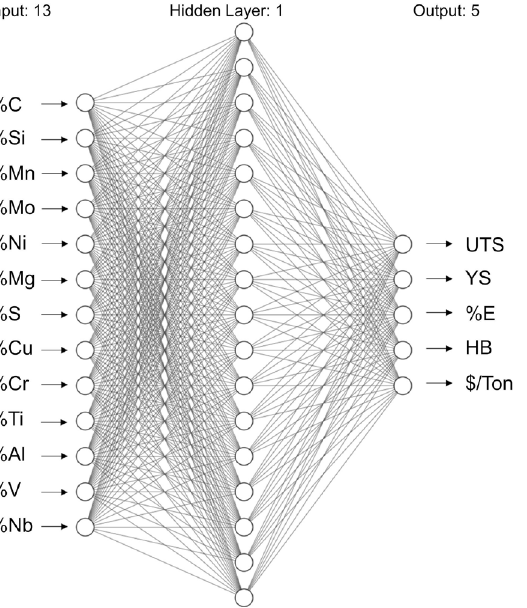
Figure 3. Architecture of the second ANN.